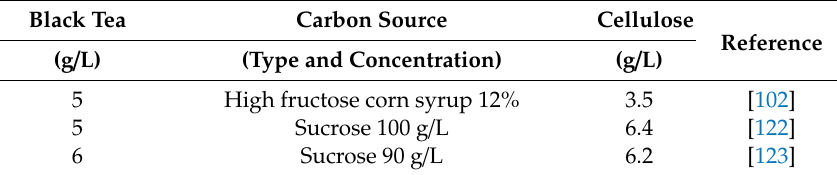
Table 4. Kombucha tea preparation for cellulose production.